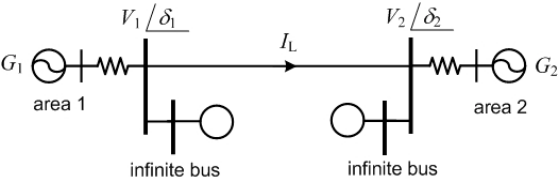
Figure 6. Equivalent system with infinite bus.